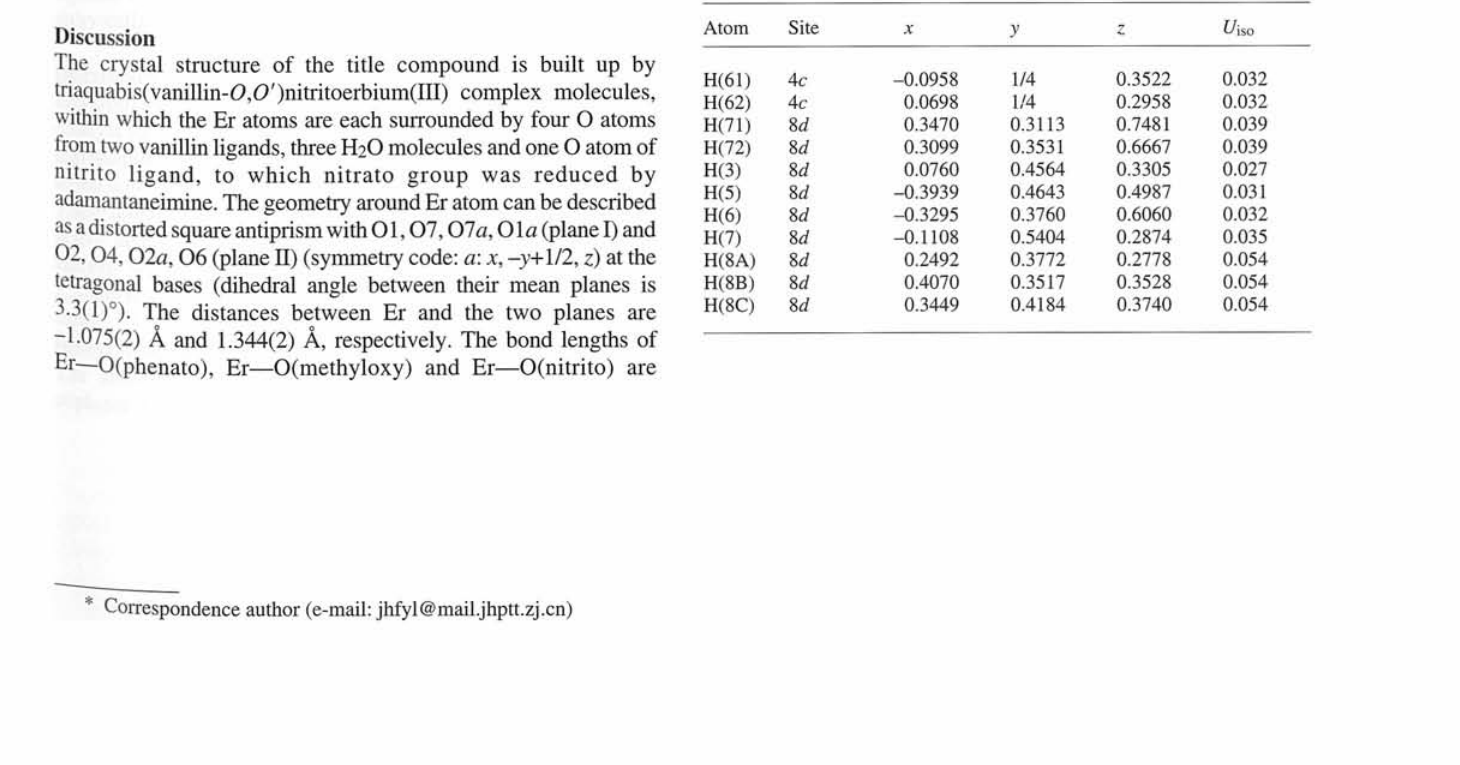
Table 2. Atomic coordinates and displacement parameters (in